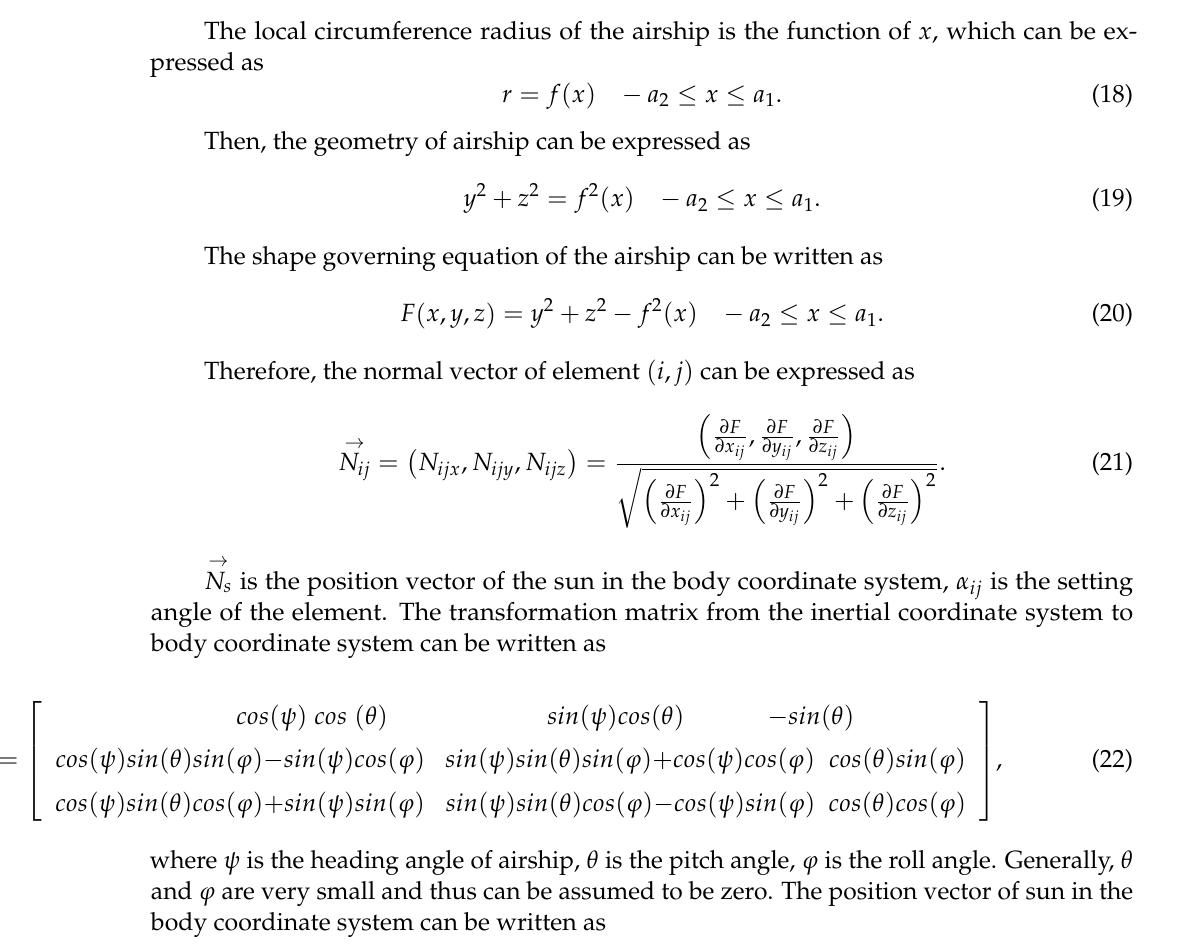
Figure 4. Sketch of the body–axis coordinate system and the solar array